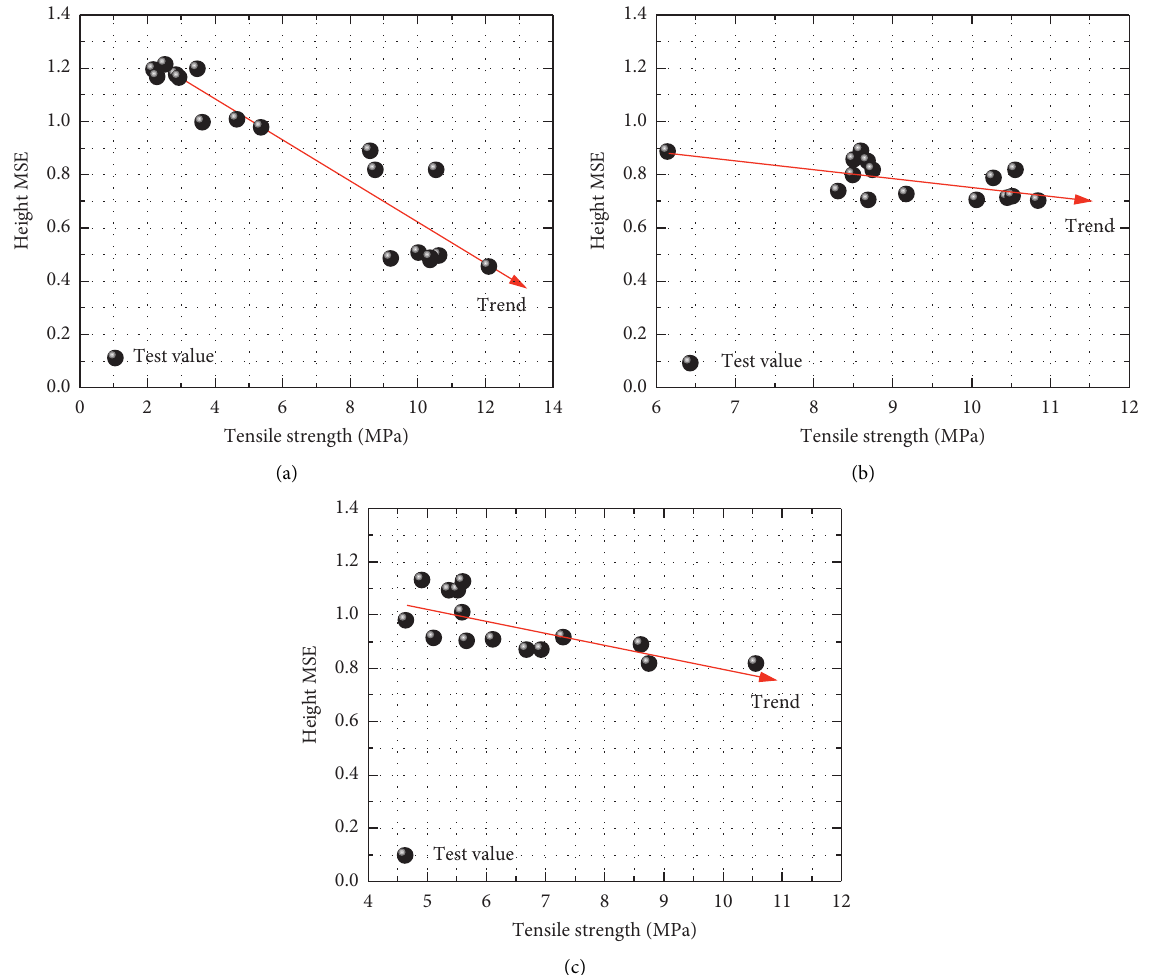
Figure 12: The relationship between the tensile strength and the height MSE. (a) HDR temperature. (b) Water temperature. (c) The number of heating-cooling